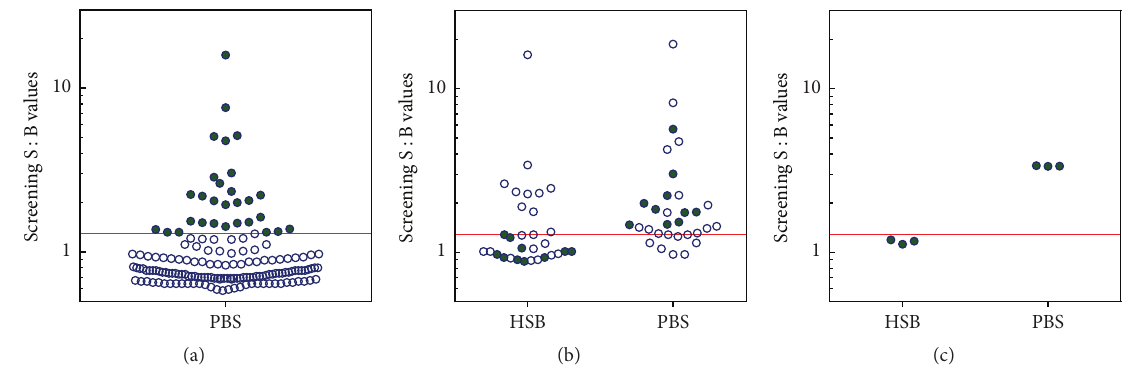
Figure 4: Preparation of the reagent monitoring control. (a) 160 commercial serum samples from drug-na¨ıve subjects diagnosed with disease B were screened using conjugated reagents stored in PBS and subjected to one freeze/thaw cycle. Solid green circles indicate samples with S :B responses at or above the screening cut point. (b) Samples selected in step (a) were tested in the screening assay using conjugated reagents stored in PBS and in HSB. Solid green circles indicate samples that changed classification from negative when tested using reagents in HSB to positive using reagents in PBS. (c) Samples identified in step (b) were pooled together and measured three times using conjugated reagents stored in HSB and using reagents in PBS. Green circles in this panel represent the three separate measurements of the final RMC pool. Red line indicates assay cut point for disease